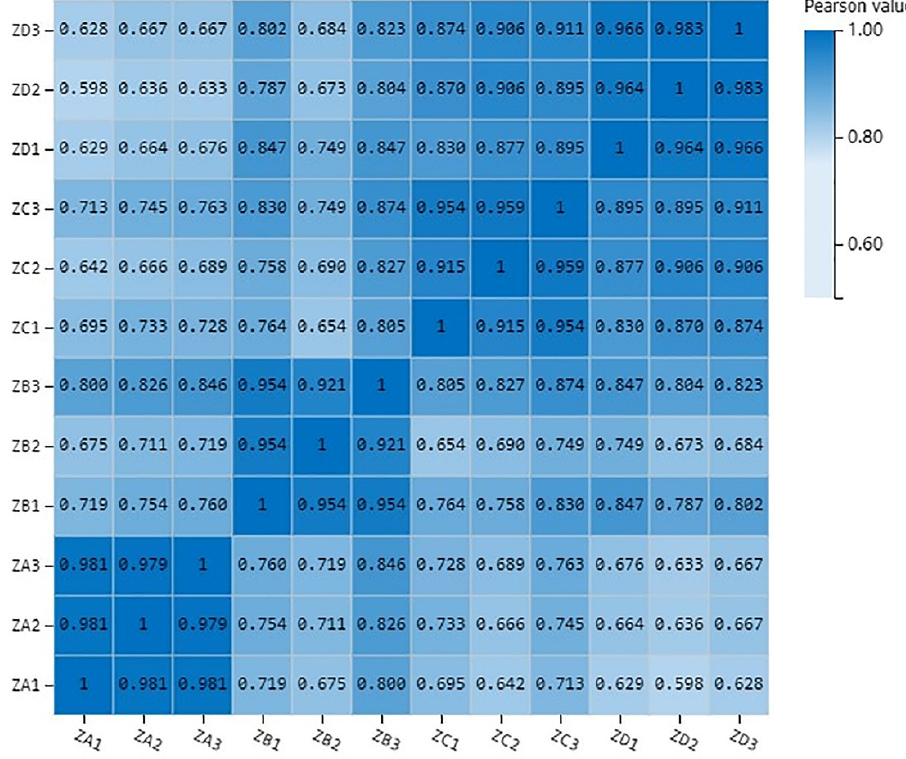
Figure 3. Biological repeat correlation of ovule sample of Korean pine.